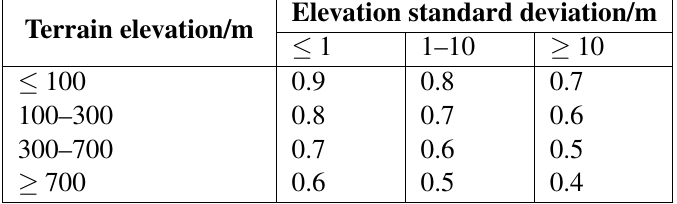
Table 4 Elevation and elevation standard deviation evaluation